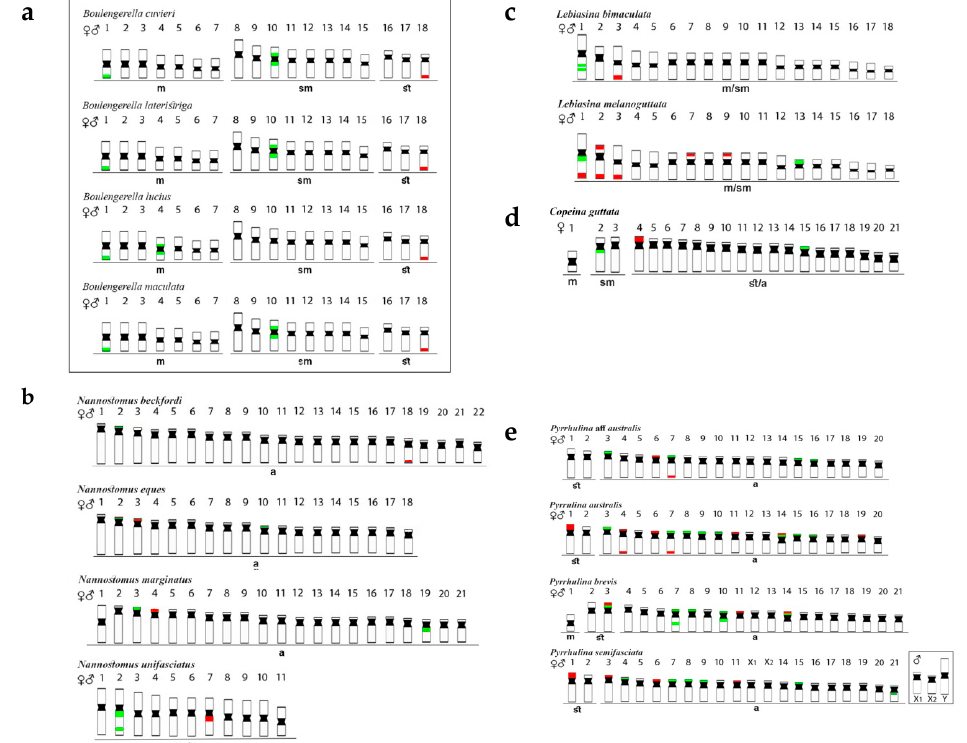
Figure 2. Schematic representation of chromosomes of Lebiasinidae and Ctenoluciidae species, highlighting the position of 5S rDNA (green) and 18S rDNA (red). The small box highlights a sex chromosome system in Pyrrhulina semifasciata , while the bigger box highlights the Ctenoluciidae members. FISH data were taken from [3–7,24]. Letters correspond to the investigated genera: ( a )— Boulengerella , ( b )— Nannostomus , ( c )— Lebiasina , ( d )— Copeina , and ( e )— Pyrrhulina